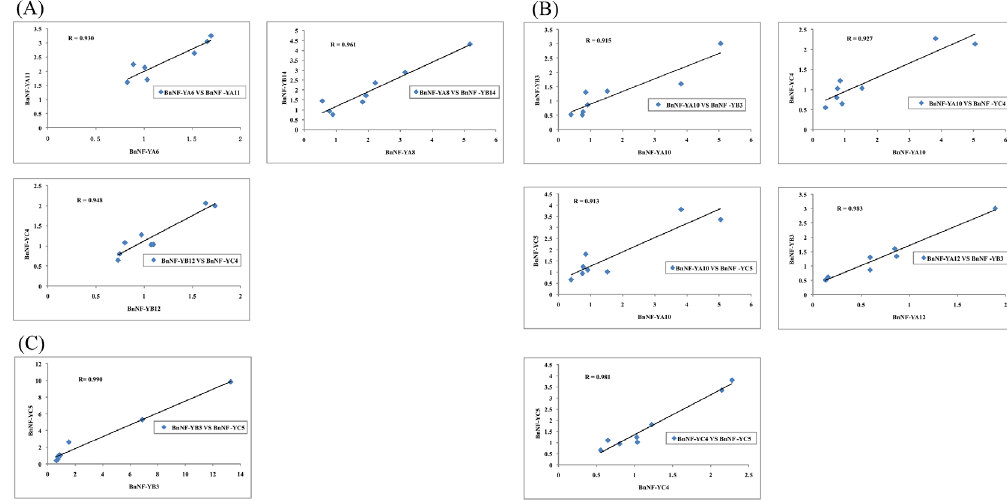
Figure 4. Correlation in expression levels of the three BnNF-Y subfamily members. Correlated gene expression under salinity (A); drought (B); and ABA (C) treatments. Relative expression levels including 8 data points (relative NF-Y gene expression levels with and without treatments at 1 h or 3 h compared to the same 0-h samples) are used for each gene according to Fig. S1, S2, and S3. These data were fitted using linear regression analysis.